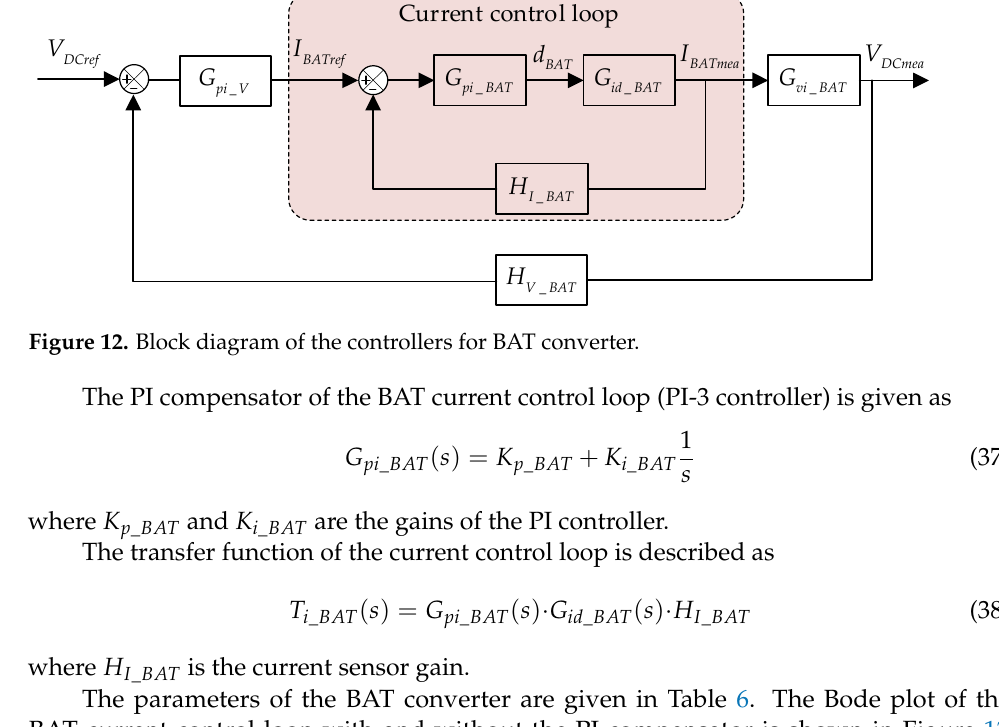
. Figure 13. Bode diagram of the BAT current control loop.